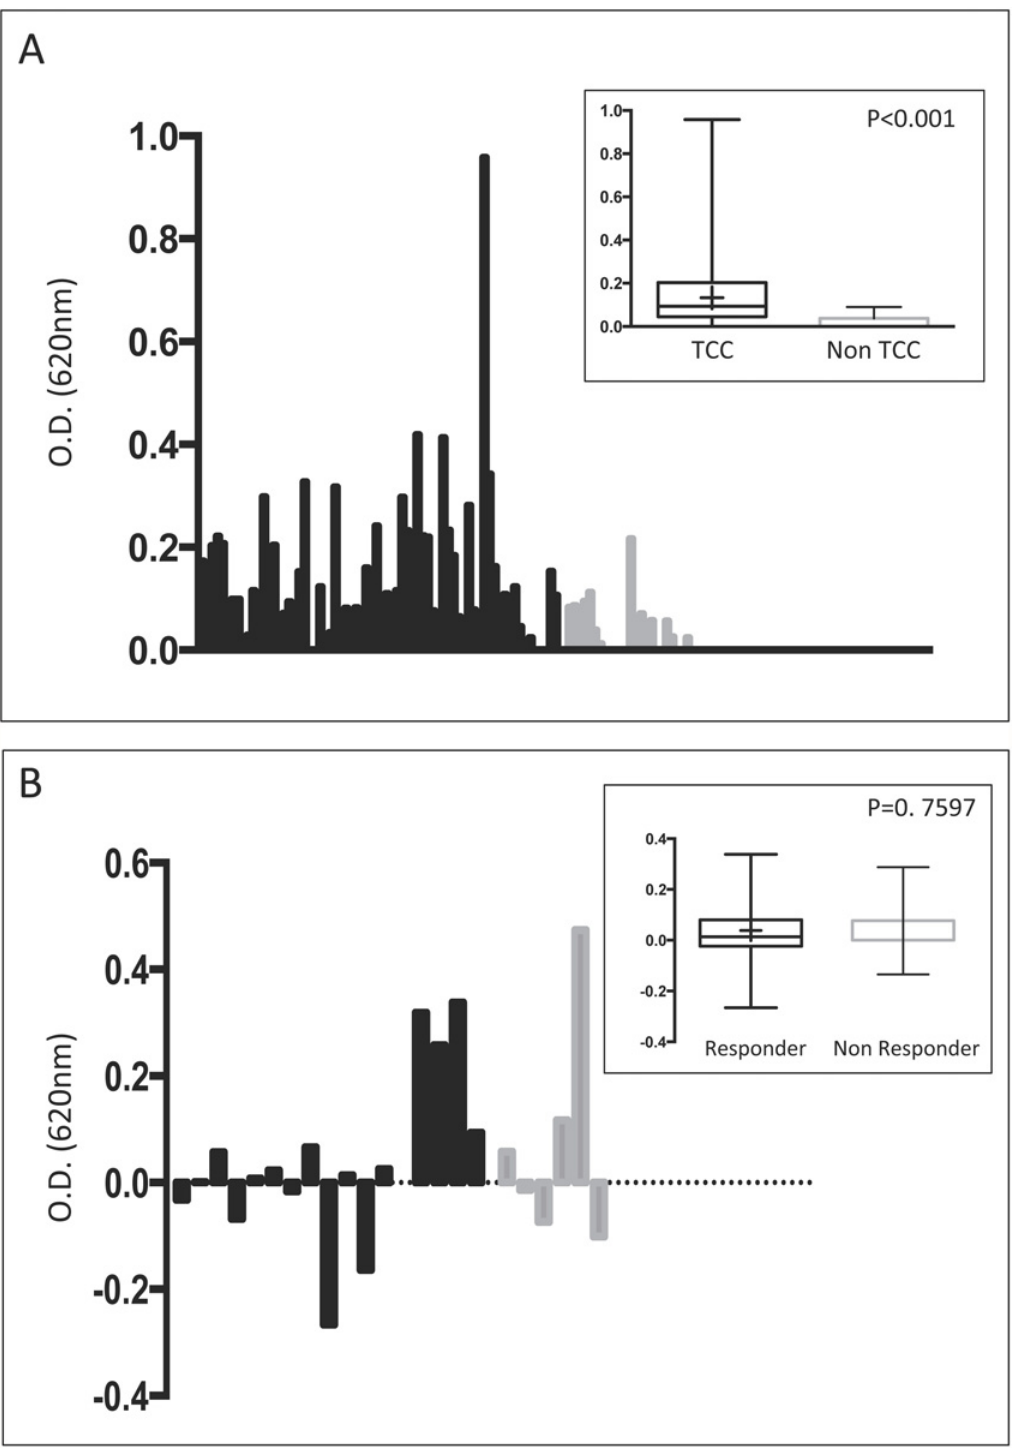
Fig 5. ELISA analysis of anti Ubiquitin titers. Left axis depicts absorbance/optical density (O.D.) at 620nm. A) TCC patients (black columns) have significant higher titers compared to non TCC patients (grey columns) (p < 0.001). B) Titers from patients undergoing BCG immunotherapy for high risk TCC do not differ when comparing responder (black columns) to non responder (white columns). Bars represent titer changes against Ubiquitin during BCG- therapy. Inlets depict results of Mann Whitney U test (box and whiskers plots with maximum and minimum